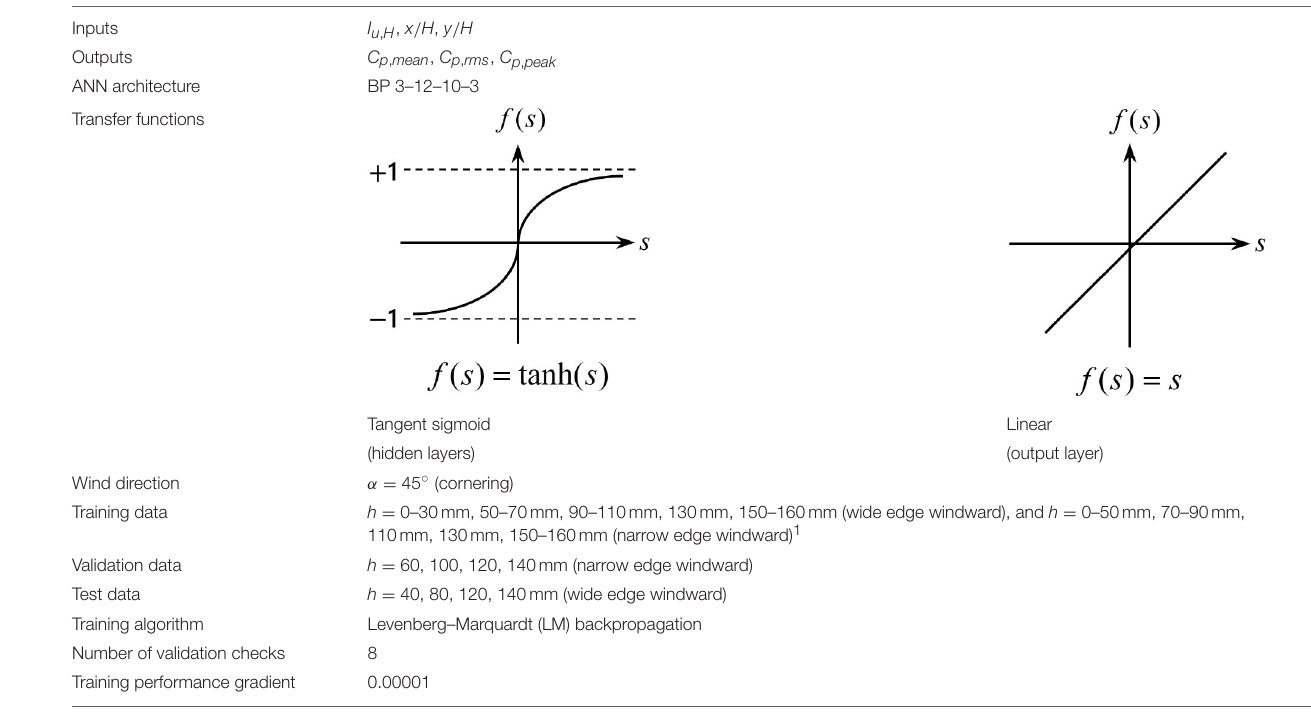
TABLE 2 | Backpropagation ANN parameters for the 1:20, 1:30, and 1:50 building